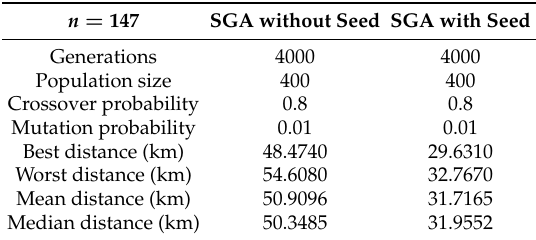
Table 11. Results of 10 executions n = 147 problem, SGA.